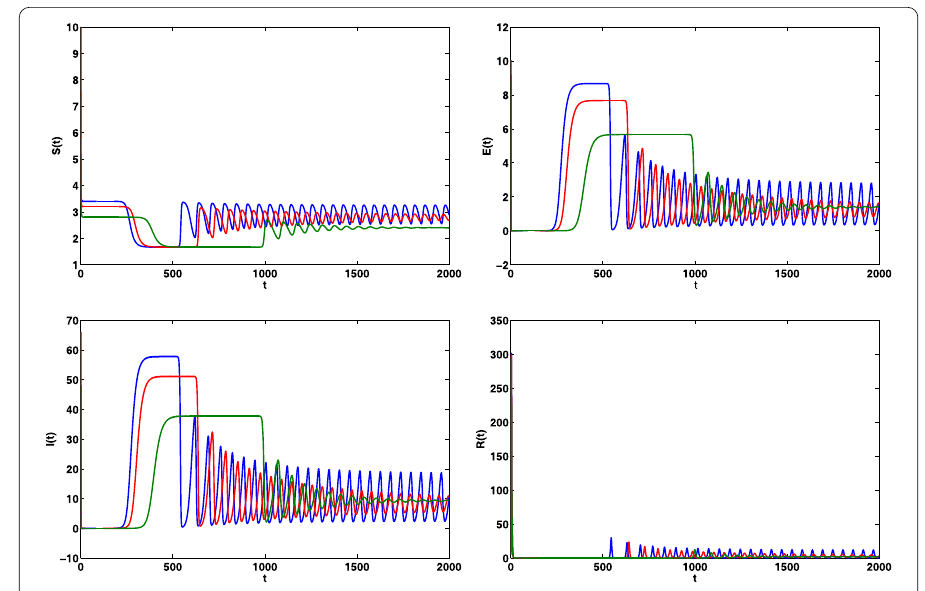
Figure 4 The phase diagram of S, E,I, R for different transmission rates at τ = 2, the remaining parameters are taken ( β = 0.05,0.10&0.15) as indicated as